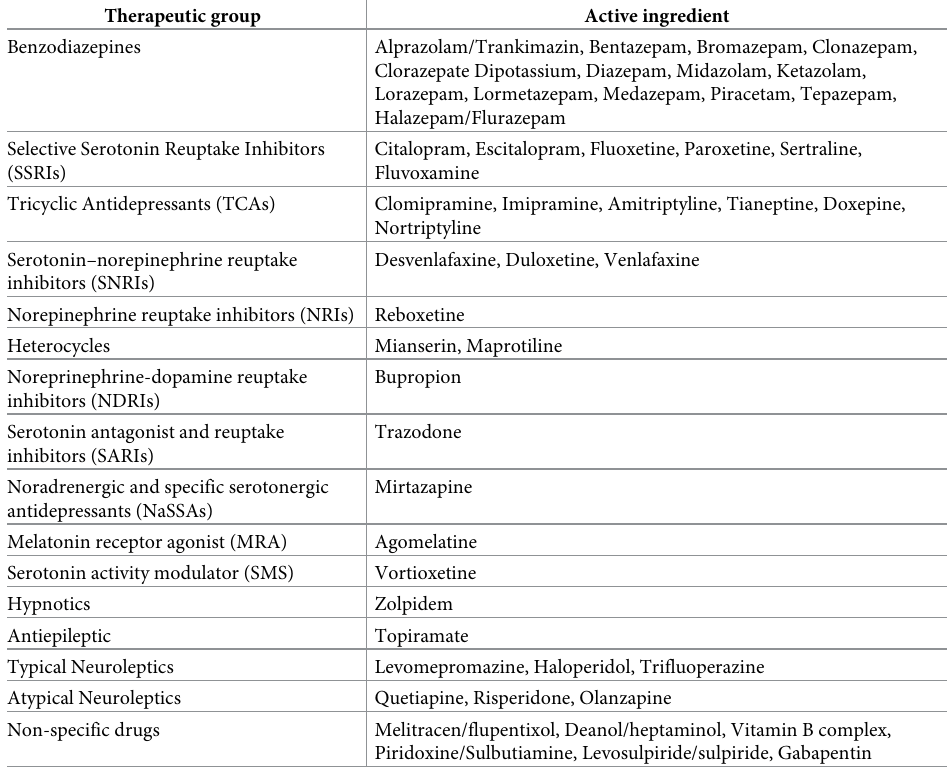
Table 1. Pharmacologic treatment according to therapeutic group (ATC